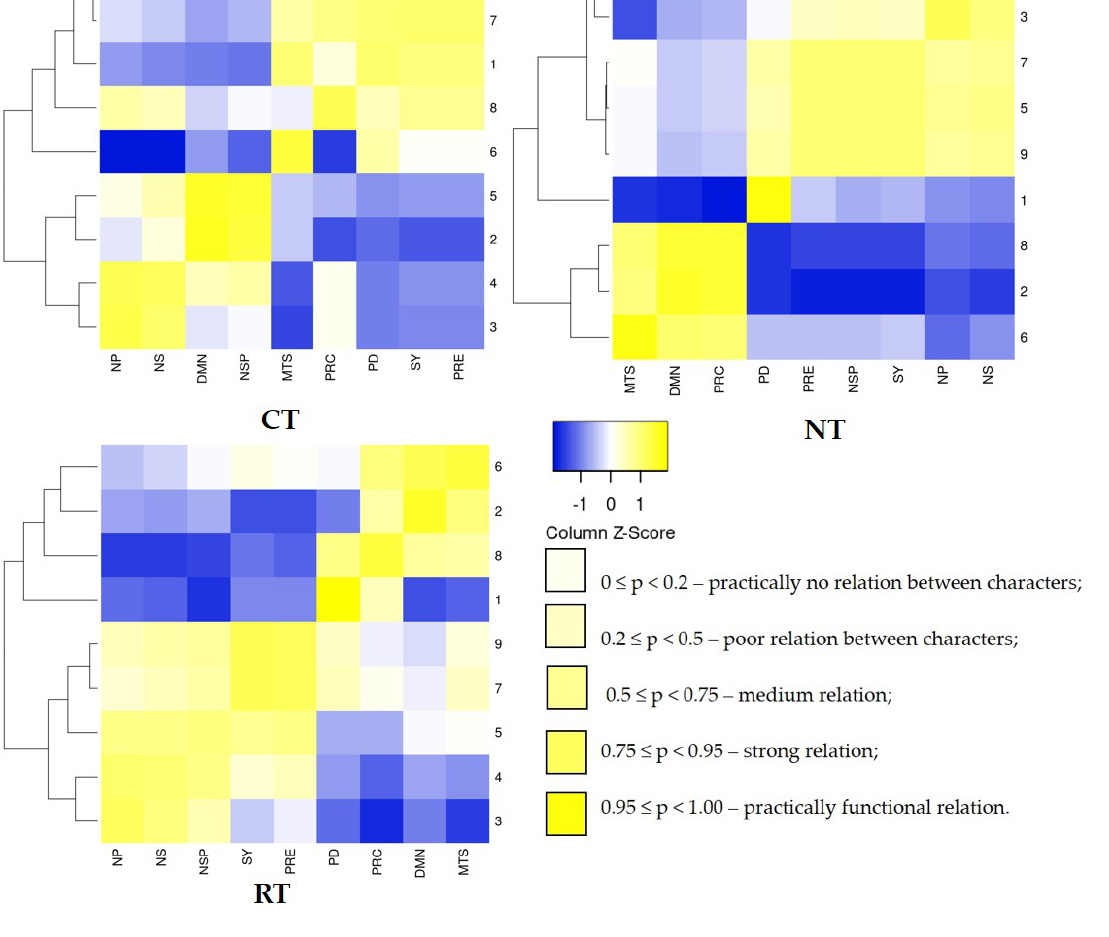
Figure 1. Correlation coefficients between analyzed parameters for narrow-leaved lupin. Tillage systems: TS, tillage system; CT, conventional tillage; RT, reduced tillage; NT, no-tillage. Parameters compared: PD, plant density; DMS, dry mass of nodule per plant; NP, number of pods per plant; NS, number of seeds per plant; NSP, number of seeds per plant pod; MTS, mass of 1000 seeds; SY, seed yield; PRC, protein content; PRE, protein efficiency.